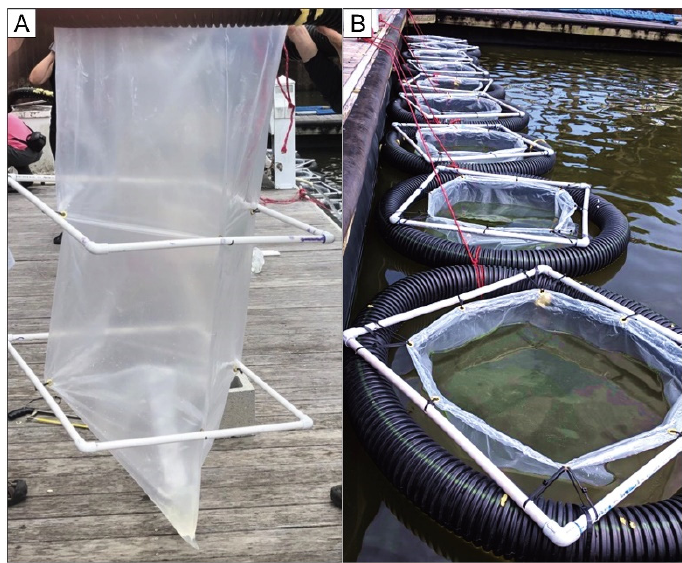
Figure 1. Mesocosm design and placement for this algaecide study conducted in 2019 at Lake Okee- chobee located in Pahokee, FL. Limnocorrals were constructed with PVC support rings throughout the body to keep the mesocosms from collapsing from external water pressure ( A ). Limnocorrals were supported by foam-filled corrugated pipe for floatation ( B ).